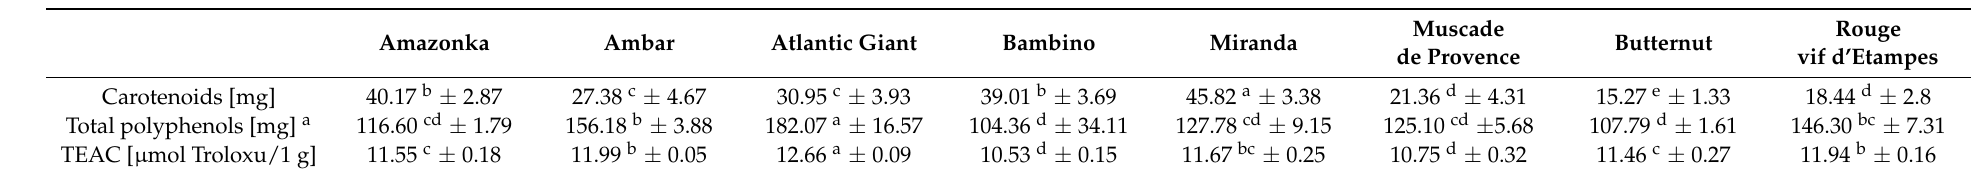
Table 2. Carotenoids, total polyphenols, and antioxidant activity of flowers of various species and varieties of pumpkins (per 100 g of fresh weight). Amazonka Ambar Atlantic